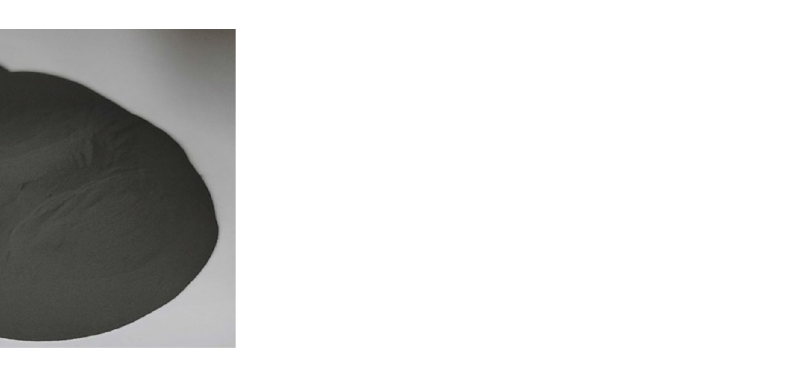
Figure 5. Tungsten